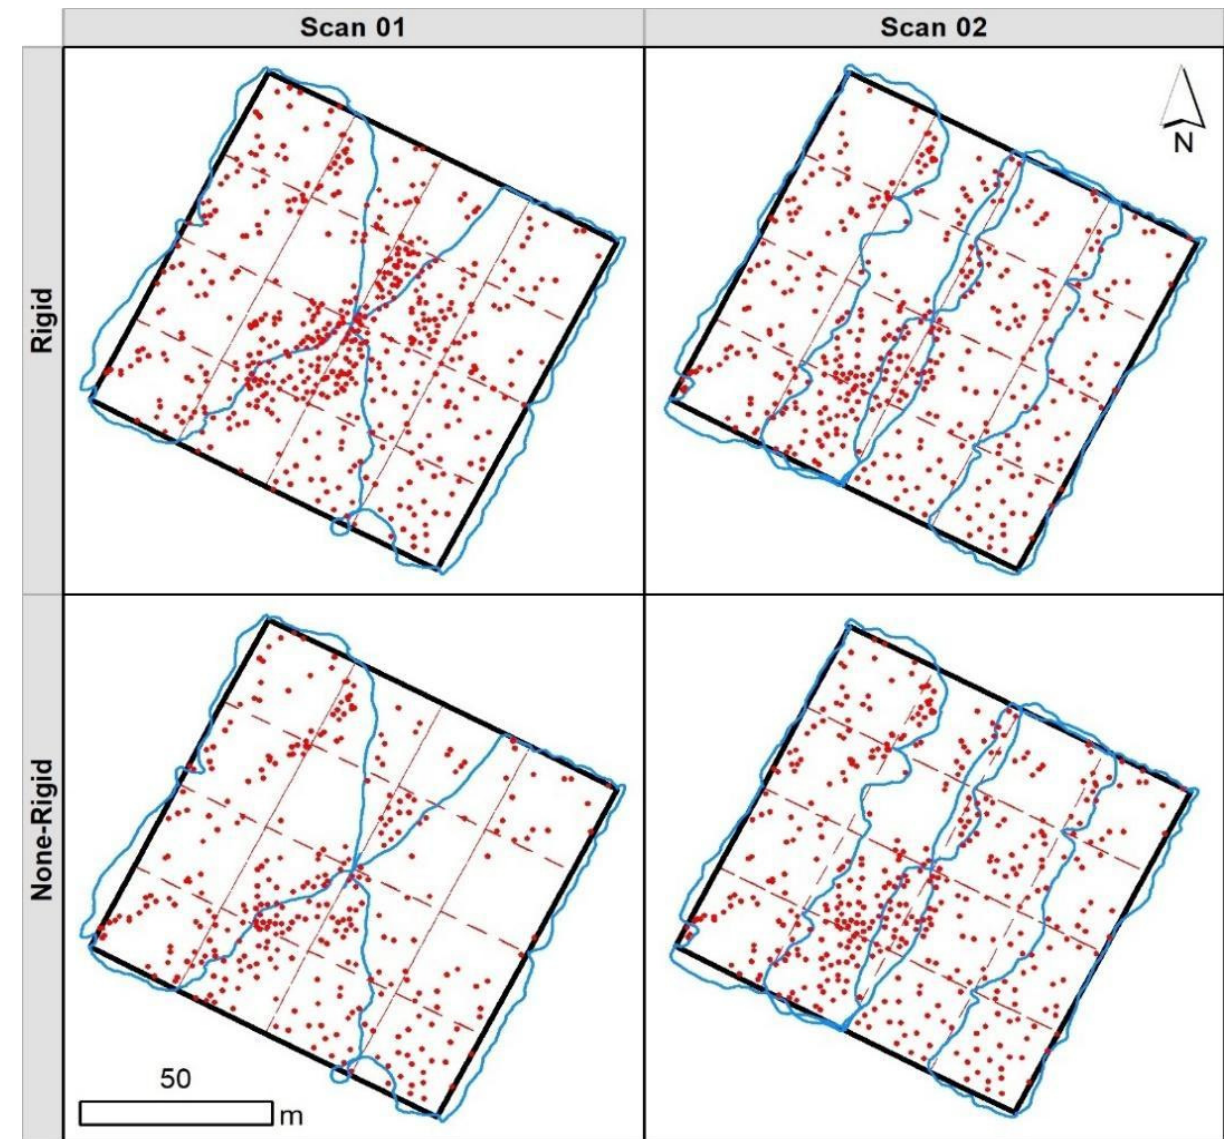
Figure 7. Spatial arrangement of tree matching pairs for Scan 01 and Scan 02 under the two trans- formation modes tested. For representation we used the coordinates of the detected tree for each pair. The scanning path is presented in blue colour for the four options tested, marteloscope are represented in solid black and sections’ boundaries (16) are represented in dashed red colour.